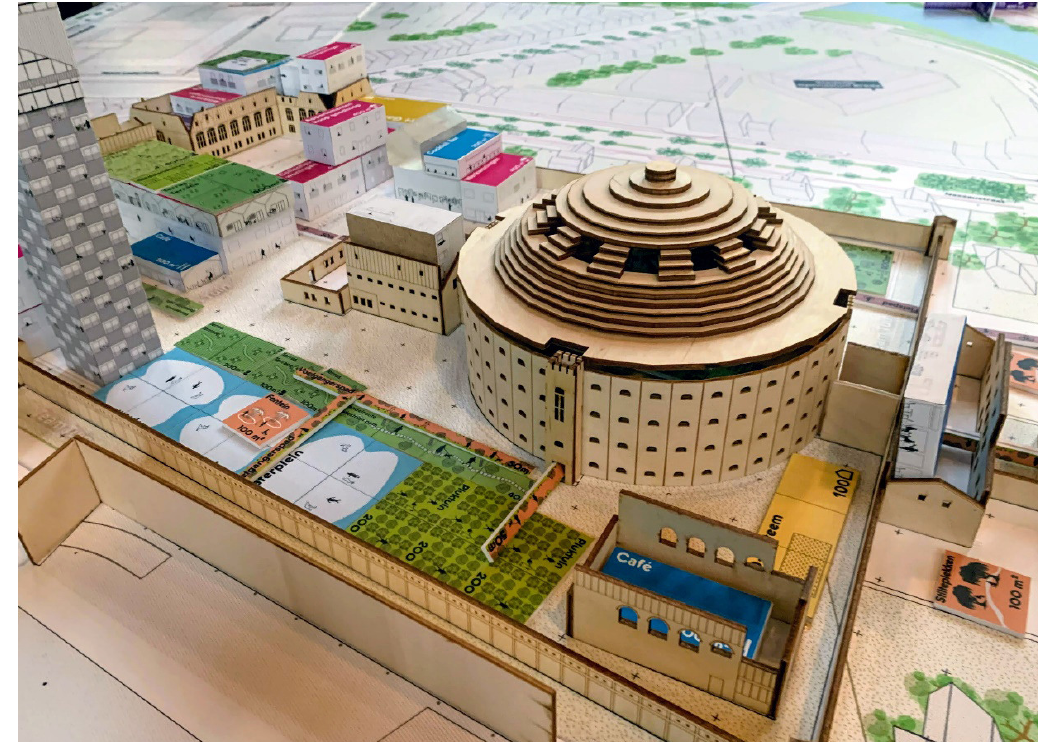
Figure 4. Data as translated to 3D building